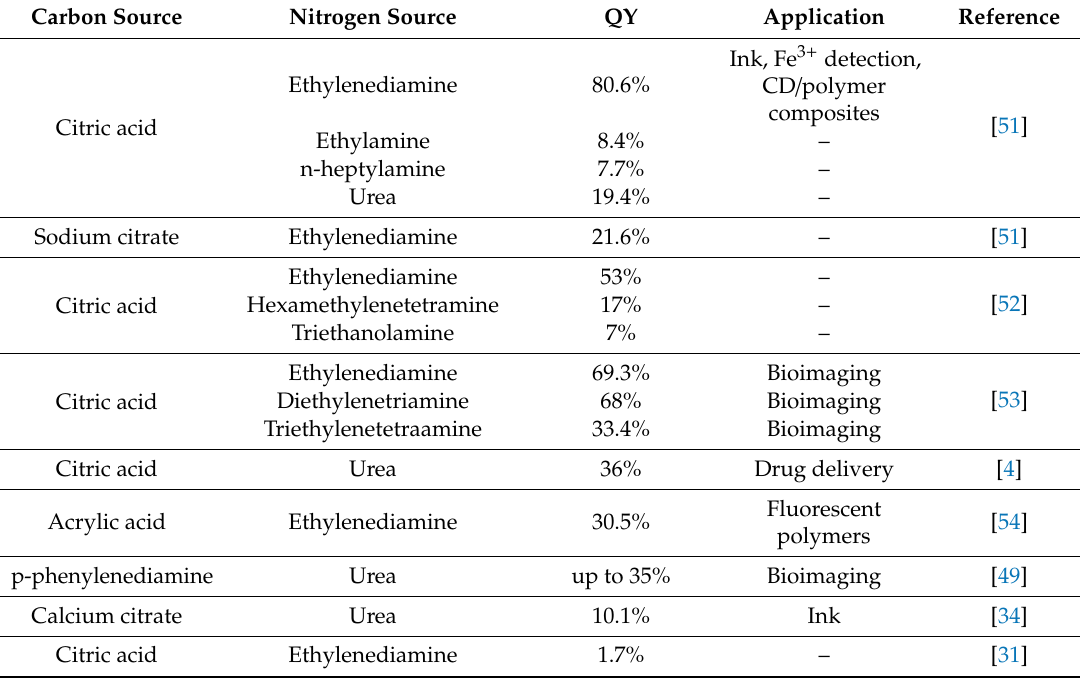
Table 1. Small molecule dual precursors for carbon dot (CD) synthesis. QY: quantum yield. Carbon